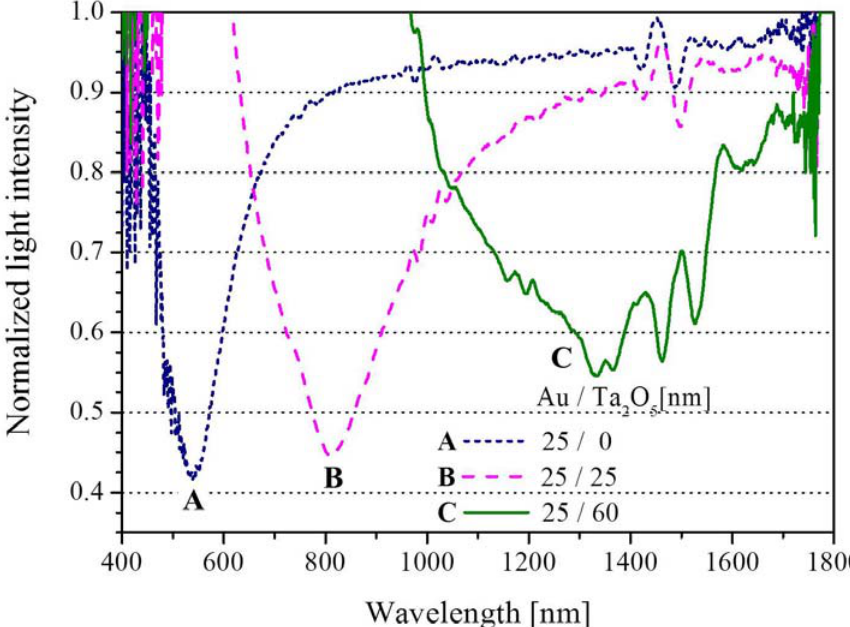
of Ta O (A: Without Ta 2 5